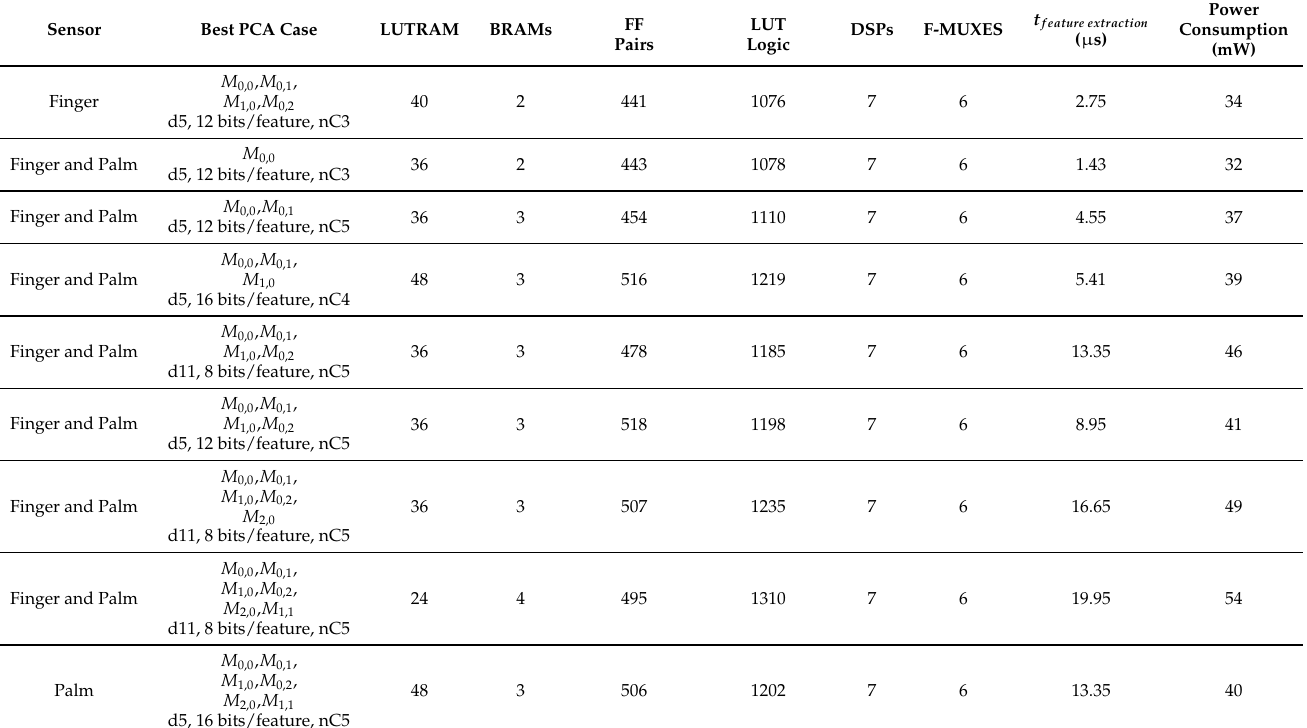
Figure 12. Comparison of a three principal component dimensional feature space for ( a ) finger, ( b ) palm, and ( c ) finger and palm. In all cases, the number of moments was six, the feature used was d5 from Table 2, and the number of bits per feature was 8. In the figure, PC1 stands for principal component 1, PC2 stands for principal component 2, and PC3 stands for principal component 3. Table 6. Performance data for the implementation of the feature extraction with PCA (VHDL features computing module plus HLS principal component analysis (PCA) computing module in Figure 7), as provided by the real Vivado IDE ® Utilization Report. The columns of the Table are the same as in Table